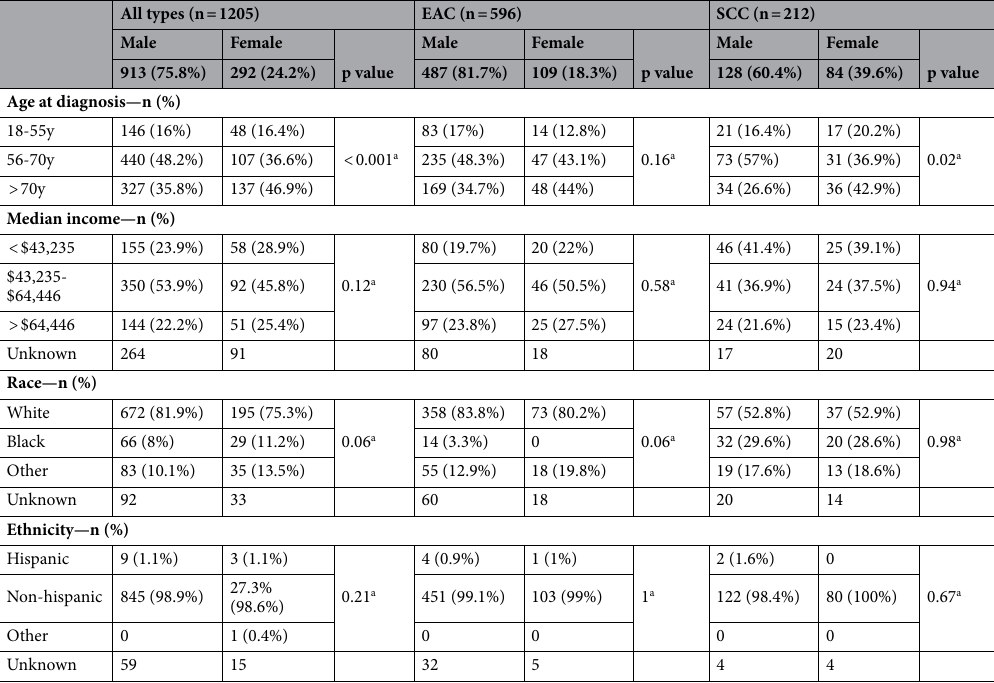
Table 1. General characteristics by sex for all types of esophageal cancer combined, esophageal adenocarcinoma (EAC) and squamous cell carcinoma (SCC), UH Seidman Cancer Center Database (2005– 2020). a Chi-Square